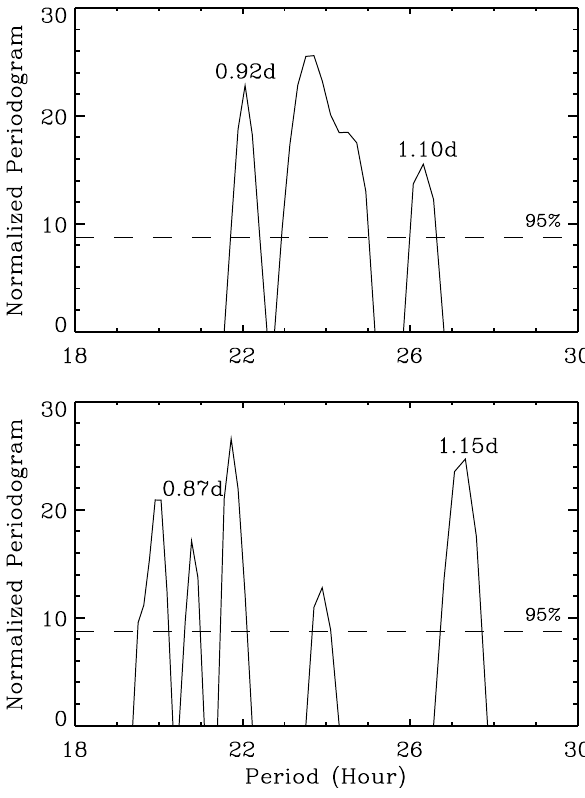
Fig. 16. Similar to Fig. 15, but at 7.3km for the zonal wind dis- turbance (upper) and at 9.0km for the meridional wind disturbance (lower) in January